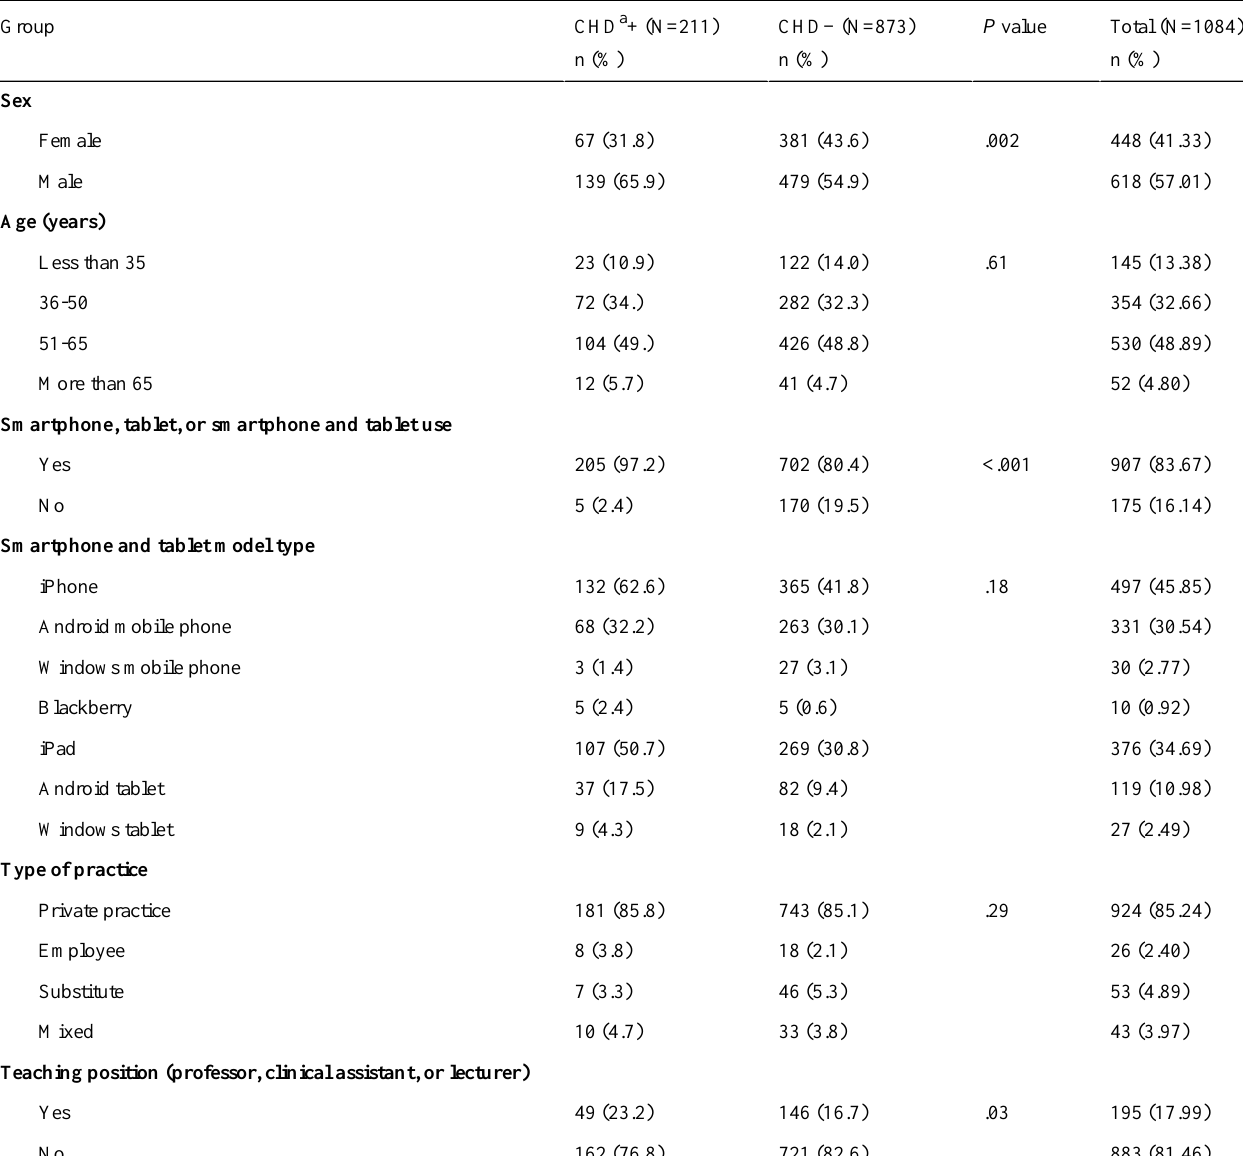
Table 1. Comparison of general practitioners’ demographics (N=1084); some general practitioners chose not to answer some questions; hence, data can be missing, and totals are not all